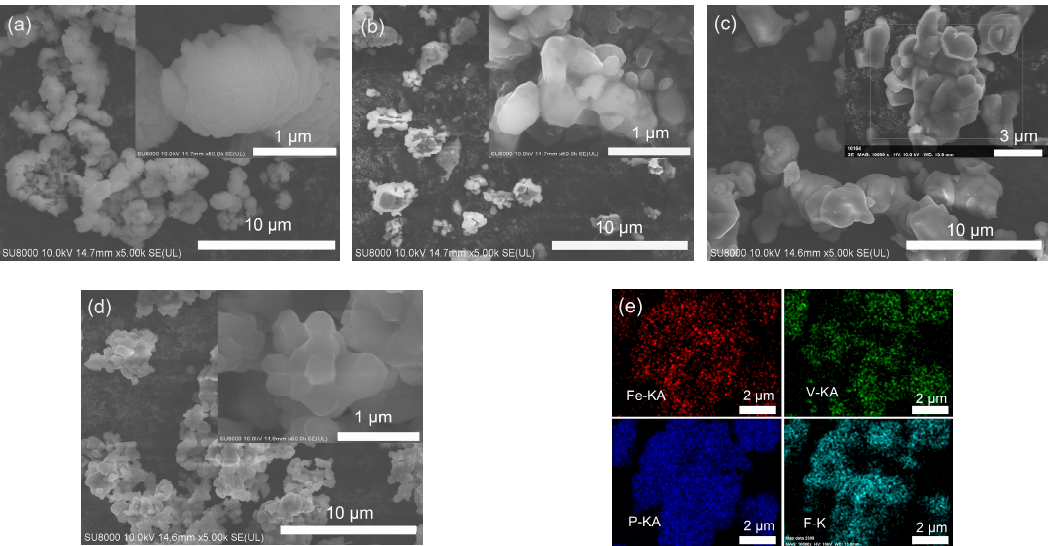
Figure 2. SEM images of FePO 4 ( a ), VPO 4 ( b ), LiFe 0.5 V 0.5 PO 4 F ( c ) and LiVPO 4 F ( d ), and the EDS mapping of LiFe 0.5 V 0.5 PO 4 F ( e ) from the inset in Figure 2c.